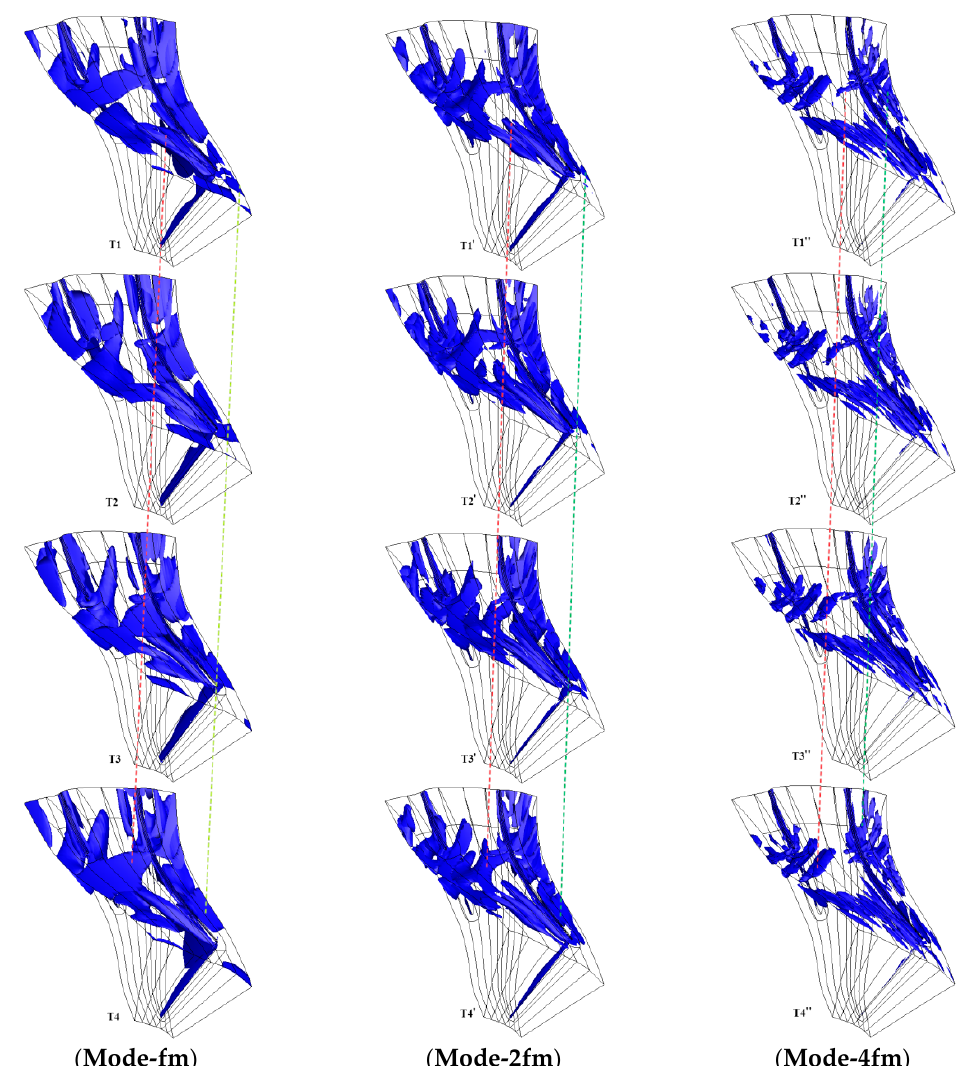
Figure 7. Dominant structure of uncontrolled compressor.